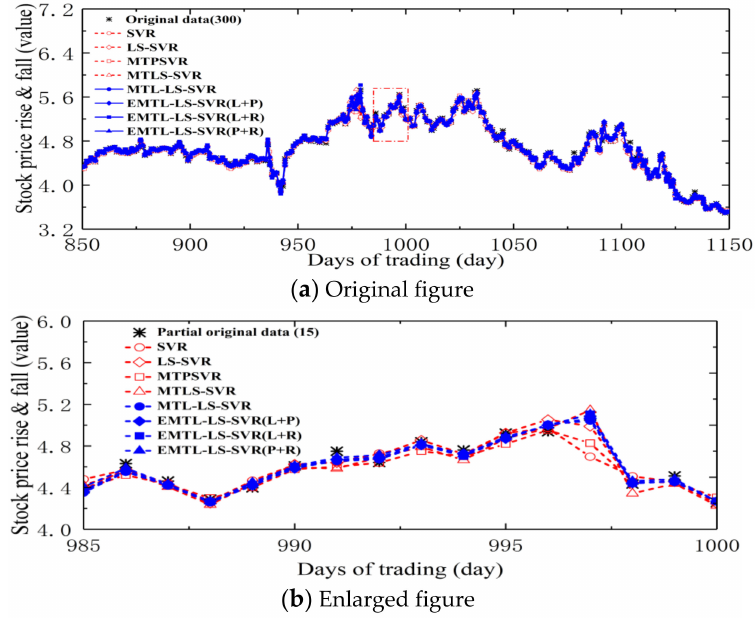
Figure 11. Predictions of different regression models on stock opening price for BOC ( a ) Original figure, ( b ) Enlarged figure.